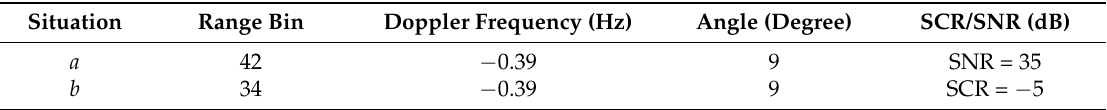
Table 1. The information of the injected targets.